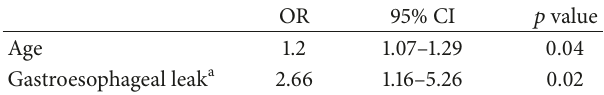
Table 5: Multivariate logistic regression analysis of risk factors for invasive fungal infection after oncologic upper GIT